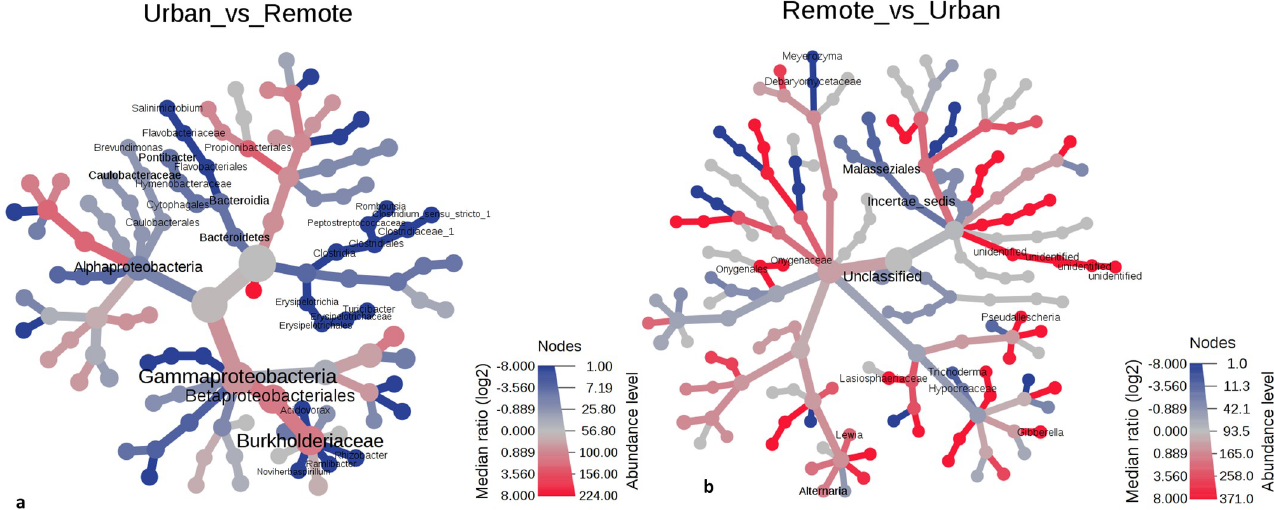
Fig 2. Spatial variations at various taxonomic levels presented on a differential heat tree (a) Bacterial and (b) Fungal communities. Only the significantly different taxonomic ranks are shown on the tree. (dark shade-remote population; light shade-urban communities).